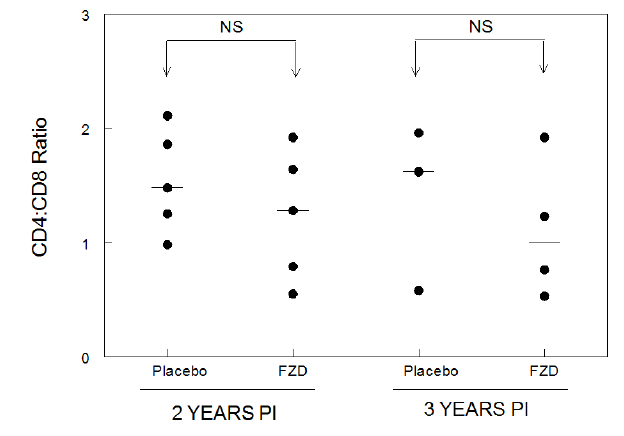
Figure 2. CD4:CD8 ratios in placebo- and FZD-treated cats during chronic FIV infection. No statistical differences in CD4:CD8 ratios were observed between Fozivudine (FZD)- treated cats and placebo-treated cats at two or three years PI. The mean CD4 to CD8 ratio is displayed as a line for each group evaluated. Five cats were evaluated for each experimental group at two years PI. Three placebo-treated and four FZD-treated cats were analyzed at three years PI. ( p < 0.05, NS = not